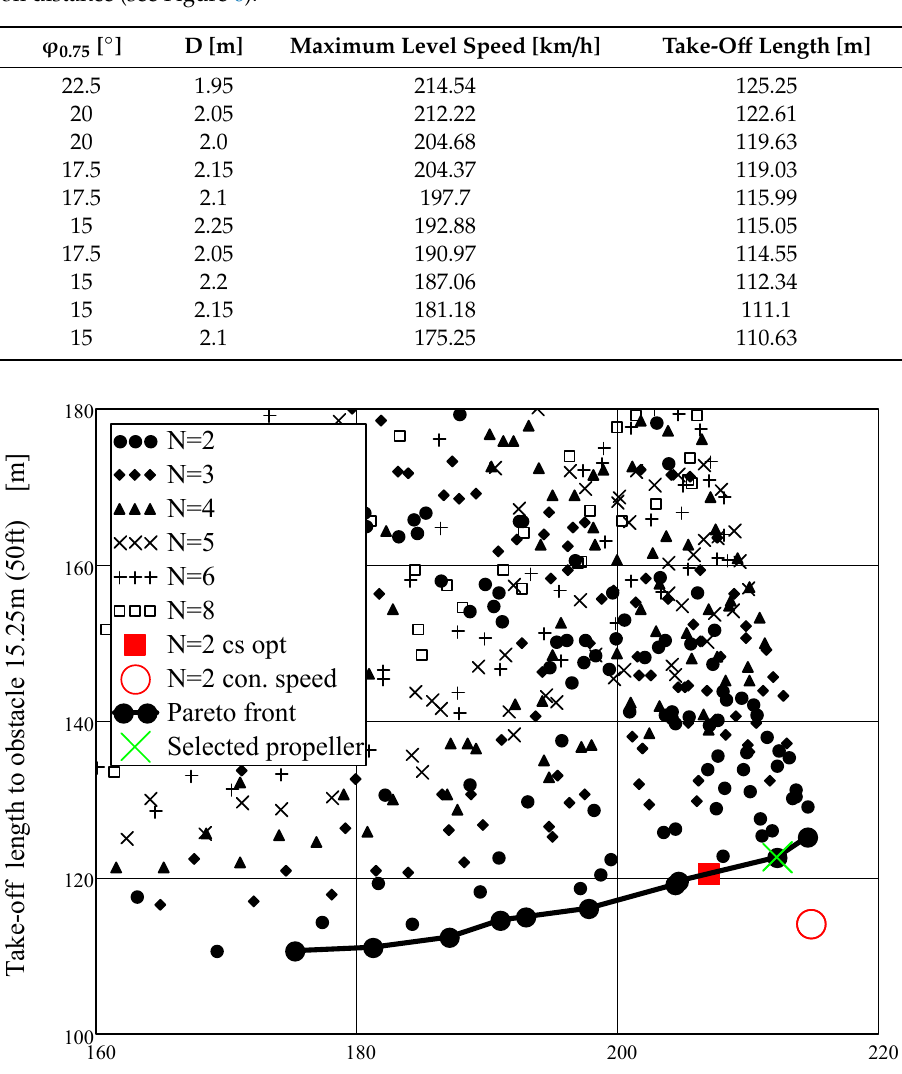
Figure 6. Pareto frontier for maximum horizontal speed (continuous engine regime) and take-off distance.